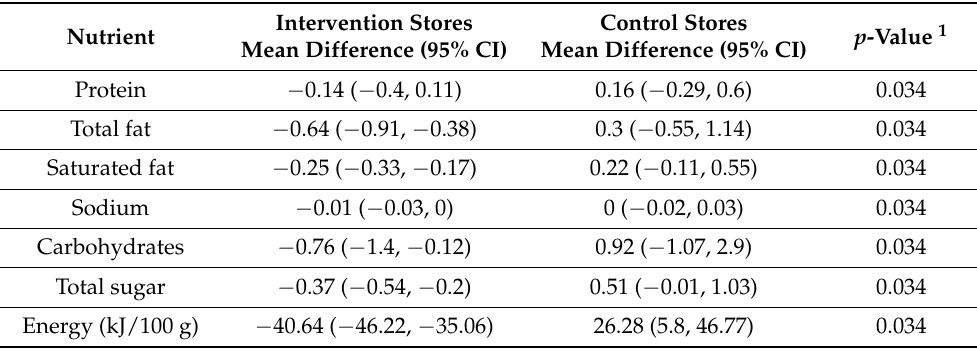
Table 2. Mean difference between post- and pre-intervention in volume of nutrients sold from packaged foods as a percentage of volume of food sold in control and intervention supermarkets, as well as mean change in energy (kJ/100 g)